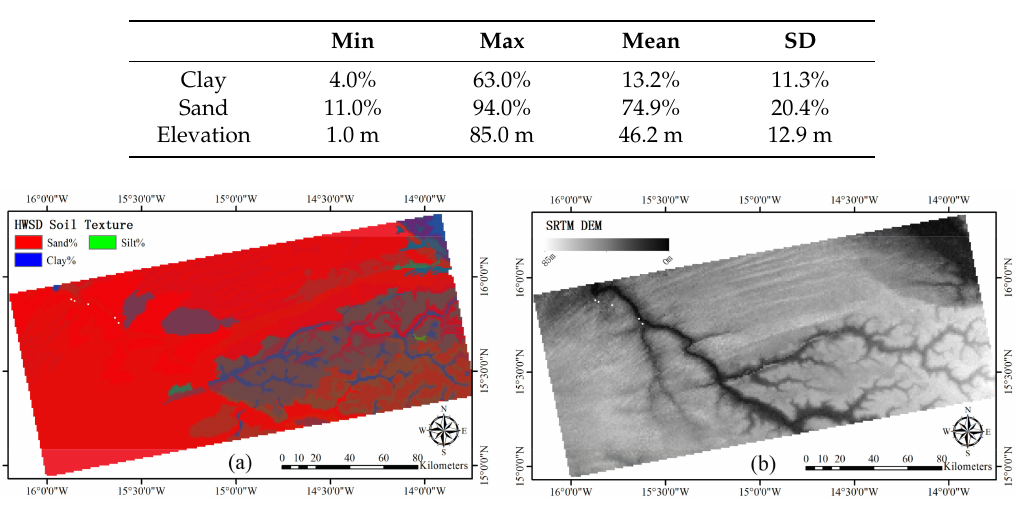
Table 1. The minimum (Min), maximum (Max), average (Mean), and standard deviation (SD) of the elevation and soil texture in the study area.